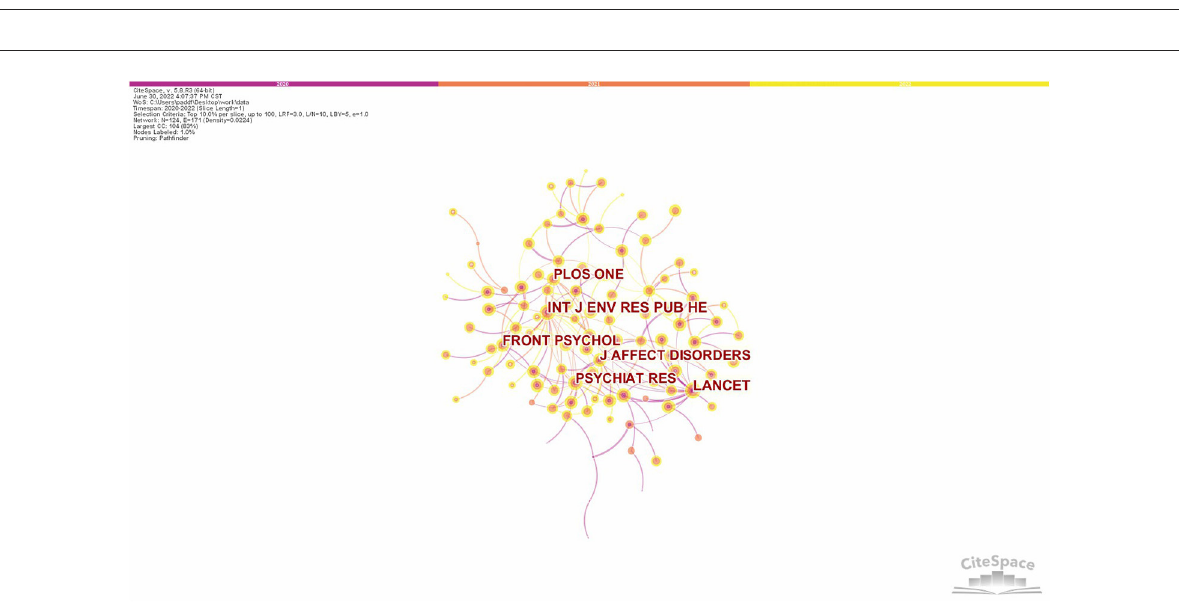
FIGURE5 Visualization map of co-citation